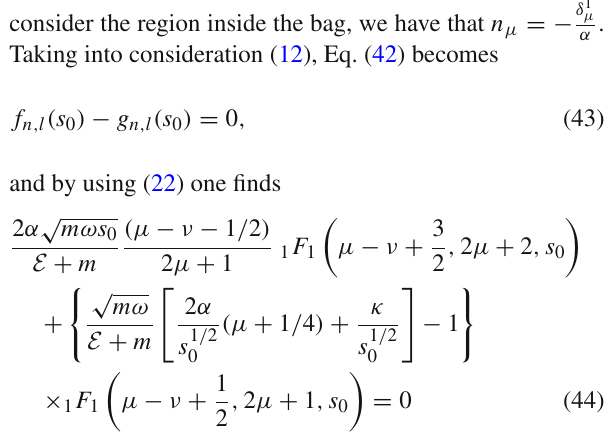
Table 2 Numerical values of the normalization constant, Eq. (41), con- sidering different values of α for l = ξ = 0 D l , n α = 1 α = 0 . 8 α = 0 .